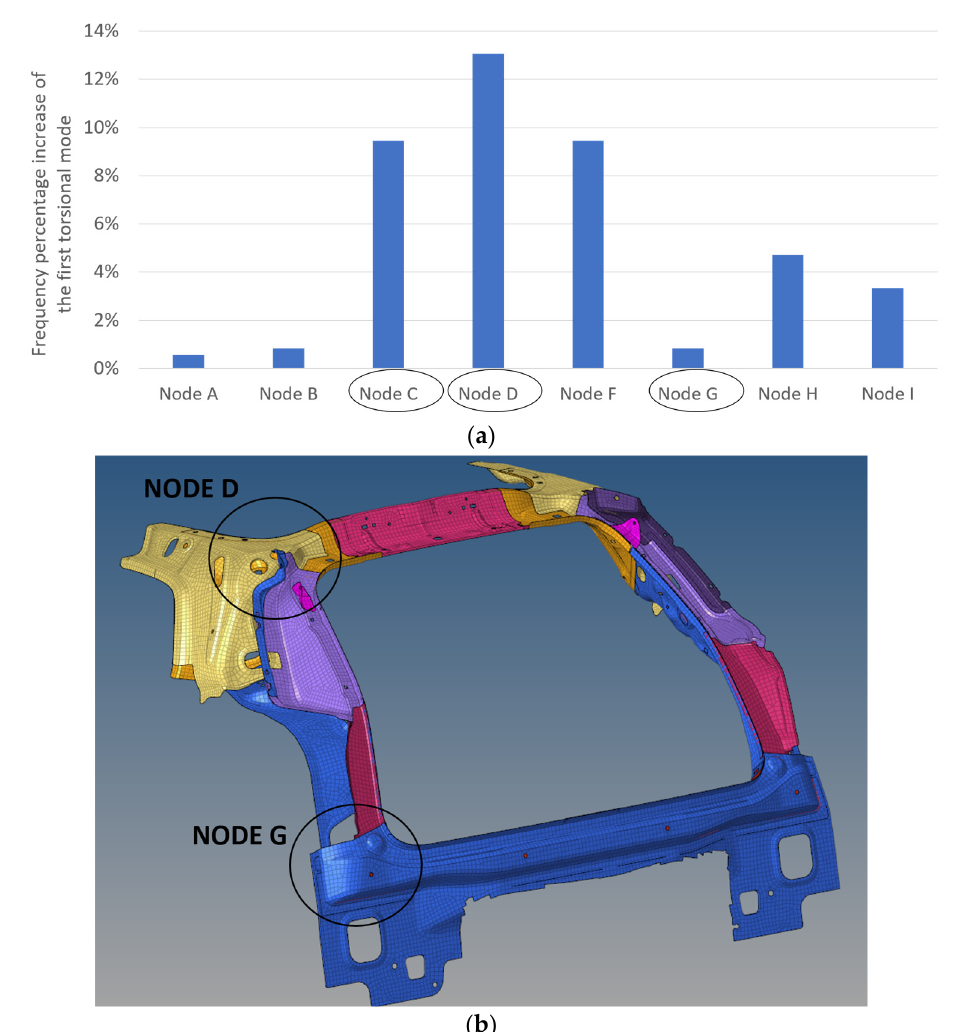
Figure 8. Frequency percentage increase in the first torsional mode in correspondence of each modified configuration ( a ), with highlights (circled in black) of most critical nodes ( b ).